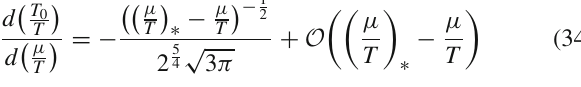
Fig. 10 Top row: the slope of E p with respect to μ hasbeenplotfor l = 0 . 2and l (cid:3) = 0 . 1andrightdiagramhasbeenplotfor l = 0 . 4 and l (cid:3) = 0 . 2. For the left (right) figure θ will be obtained 0.534 (0.526). The corresponding RE and RMS are 0 . 068 and 0 . 058 for the left panel and 0 . 053 and 0 . 074 for the right one. Note that the dE p be infinitely positive or negative at the critical point. Bottom row: the